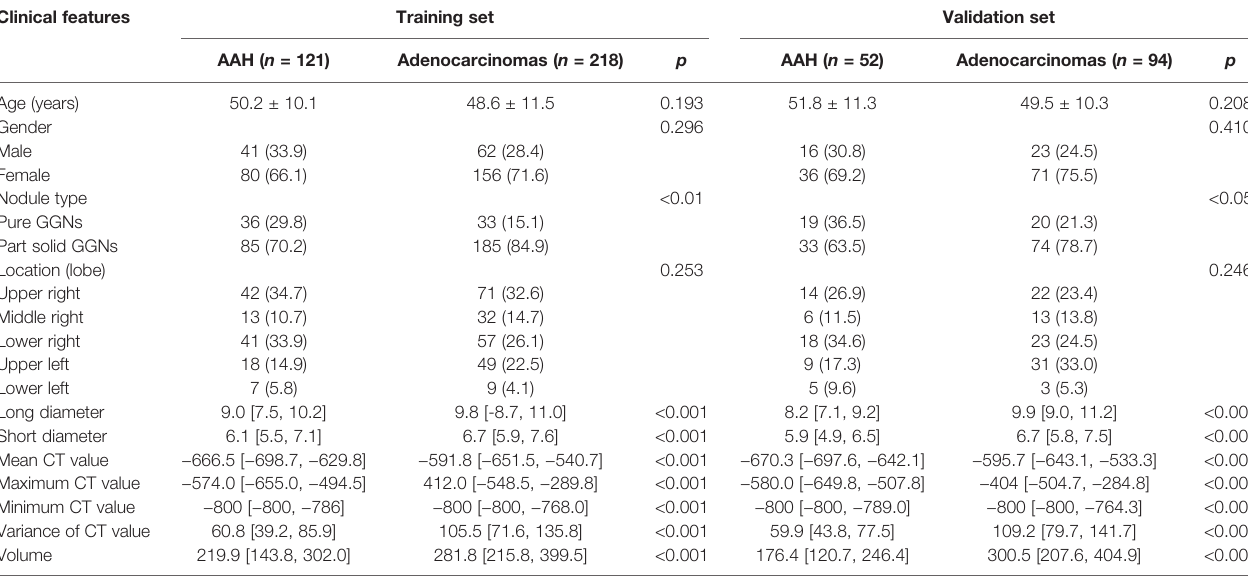
TABLE 1 | Clinical information of the cases in the training and the validation sets. Clinical features